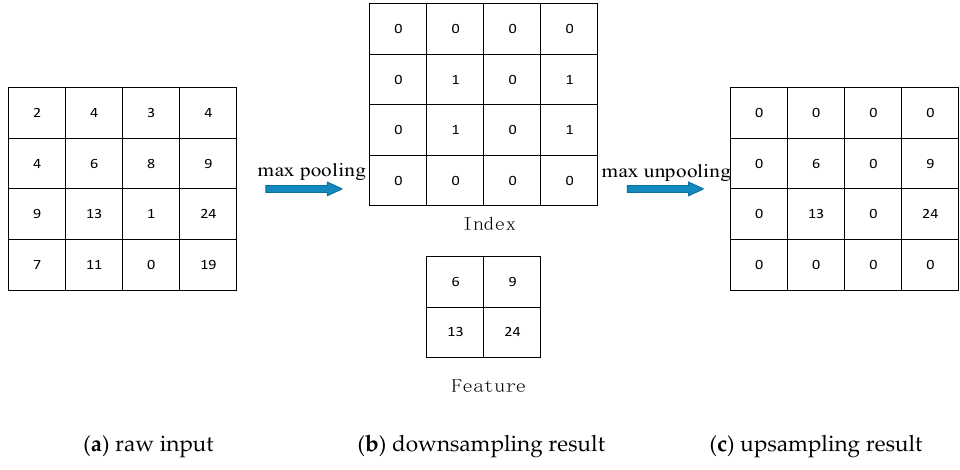
Figure 7. OctConv sampling principle.